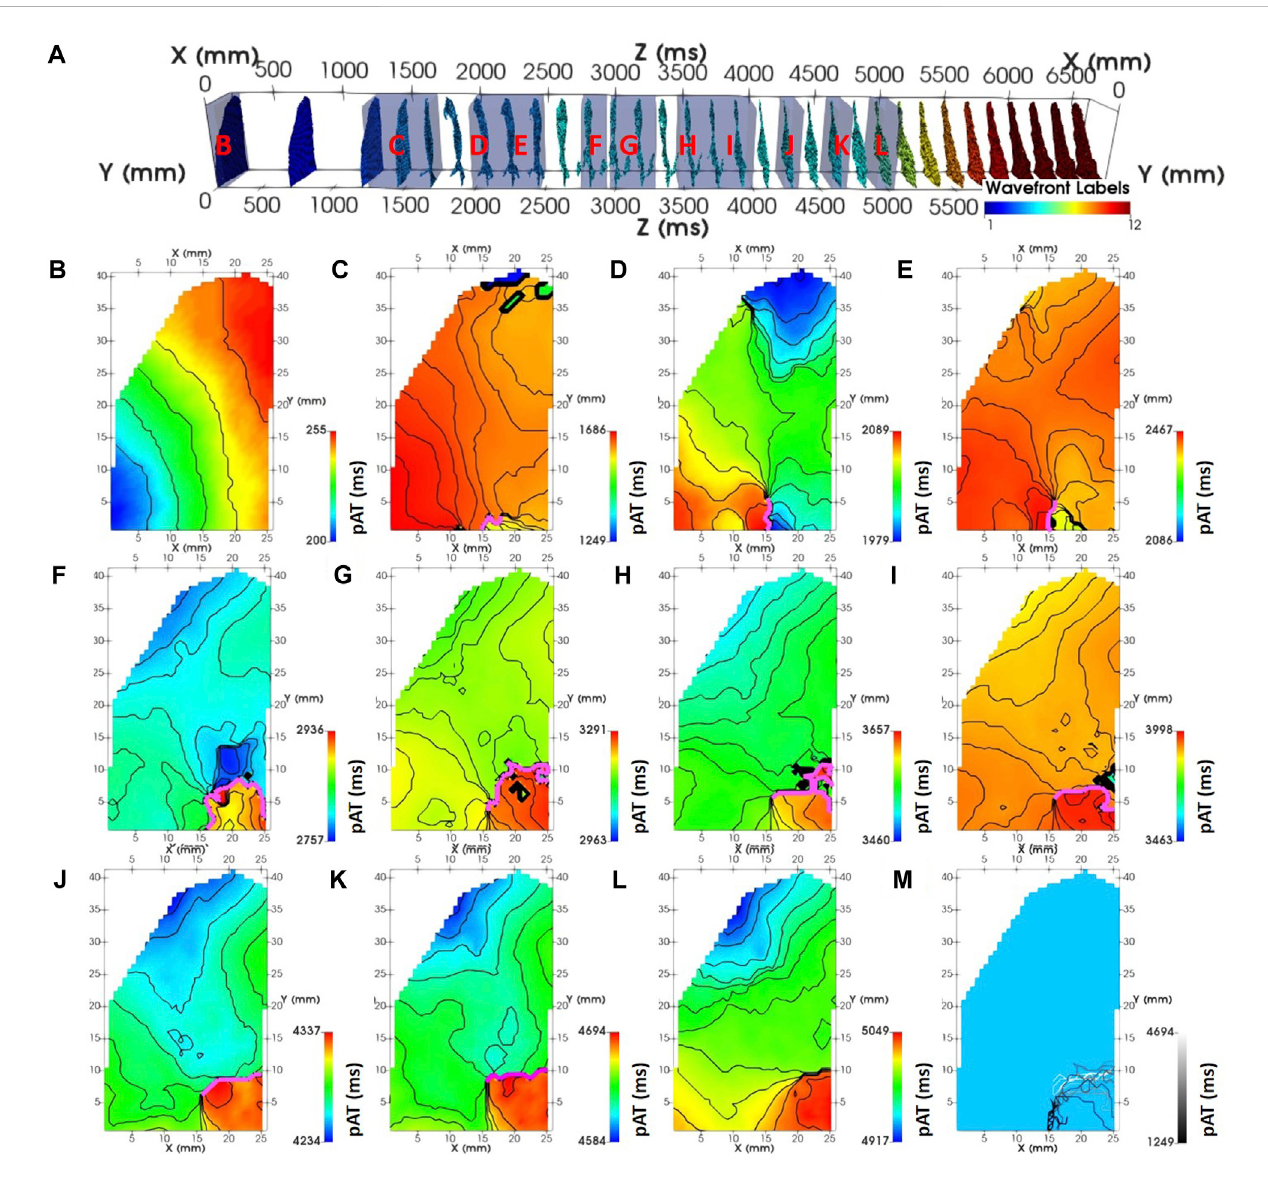
FIGURE 6 Dynamic mapping of experimental complex activity. (A) A spatio-temporal distribution of pAT points spanning pacing, induction and reentry phases of the experimental optical acquisition. pAT maps were dynamically probed for wave front labels (#): 1 (B) , 3 (C) , 5 (D – F) , 6 (G – K) , and 7 (L) . Lines of conduction slowing where the direction of maximal gradient exceedes 50 ms are annotated (pink lines). pAT windows are labelled in panel (A) (red). (M) Lines of conduction slowing superimposed. Lines are colored according to their average